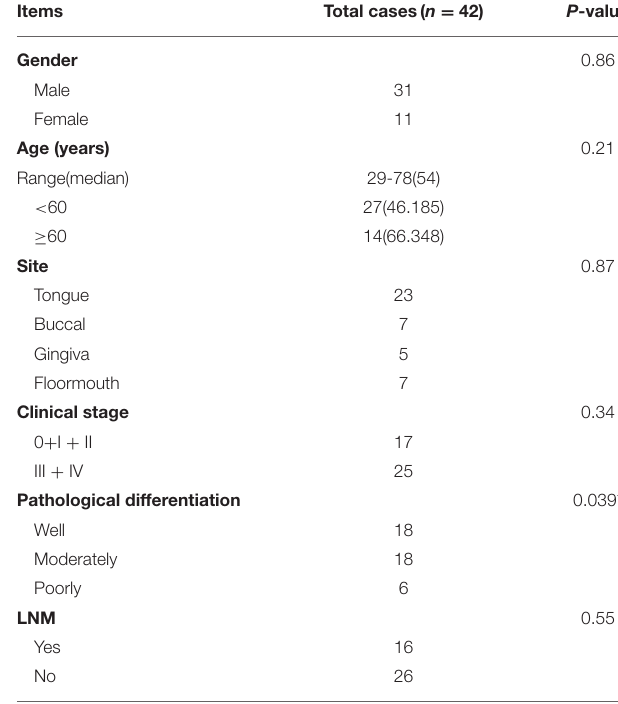
TABLE 4 | Correlation between hsa_circ_000334 expression and clinicopathological characteristics in 42 oral squamous cell carcinoma patients.